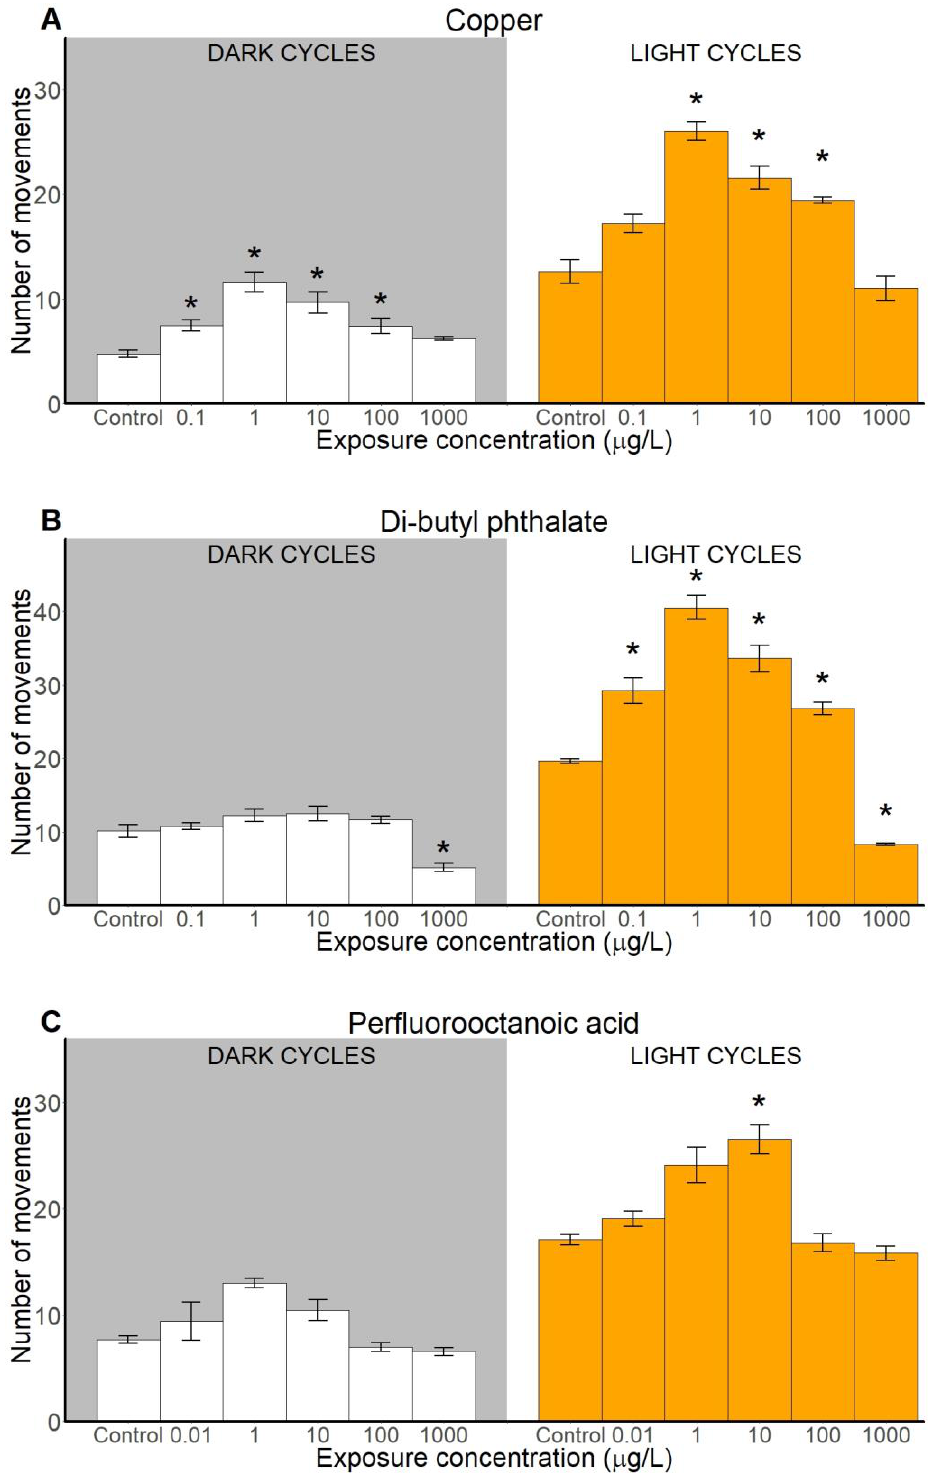
Figure 2. Locomotive activity (measured as number of movements) of sand goby larvae exposed to copper ( A ), di-butyl phthalate ( B ), and perfluorooctanoic acid ( C ). Results presented as means ± SEM (standard error of the mean) for dark (left) and light (right) cycles. Statistically significant differences ( p < 0.05) between control and other treatments are indicated with asterisks (*), ( n ≥ 31 ).